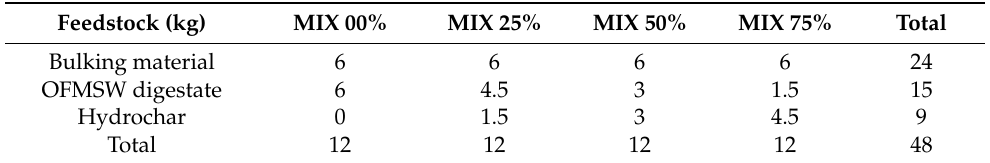
Table 2. Fractions (in kg) mixed for each condition of percentage of hydrochar substituting the organic fraction of municipal solid waste (OFMSW) digestate. Feedstock (kg) MIX 00% MIX 25% MIX